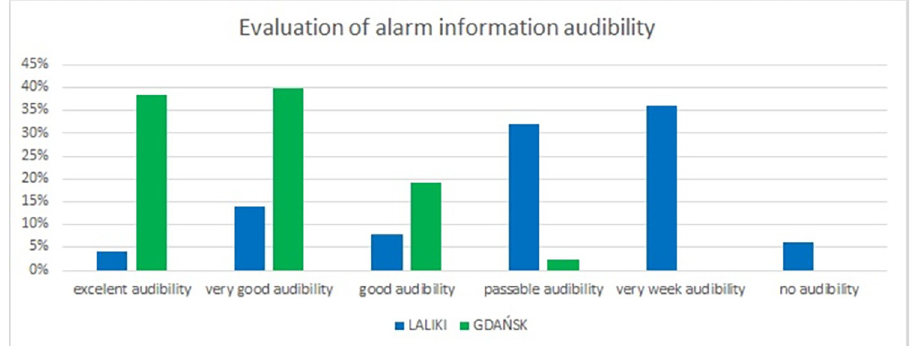
Fig 9. Pedestrians’ estimation of the audibility of the alarm message in the tunnel (prerecorded) (results from Experiment 1).